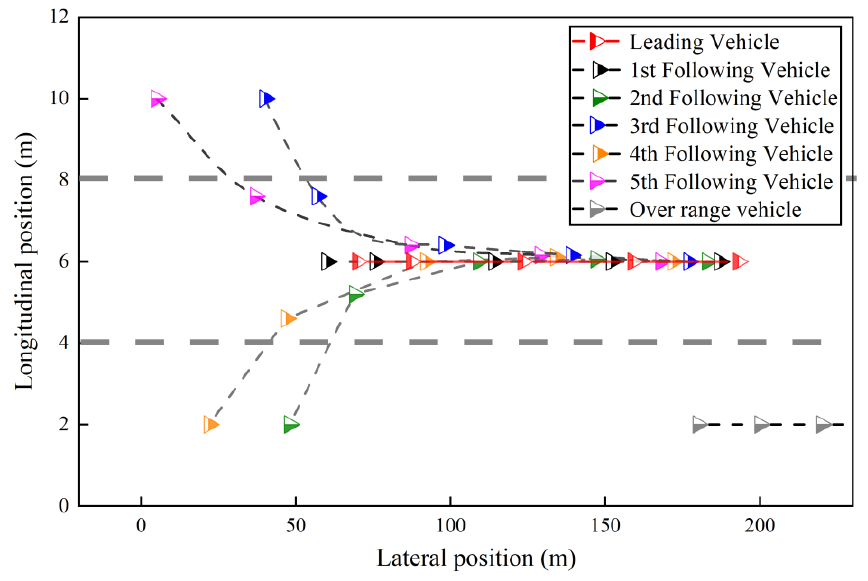
Figure 9. The trajectories of the CAVs during the platoon formation process (scenario III).